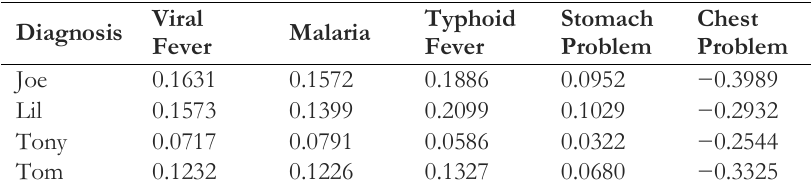
Table 3. Results for medical